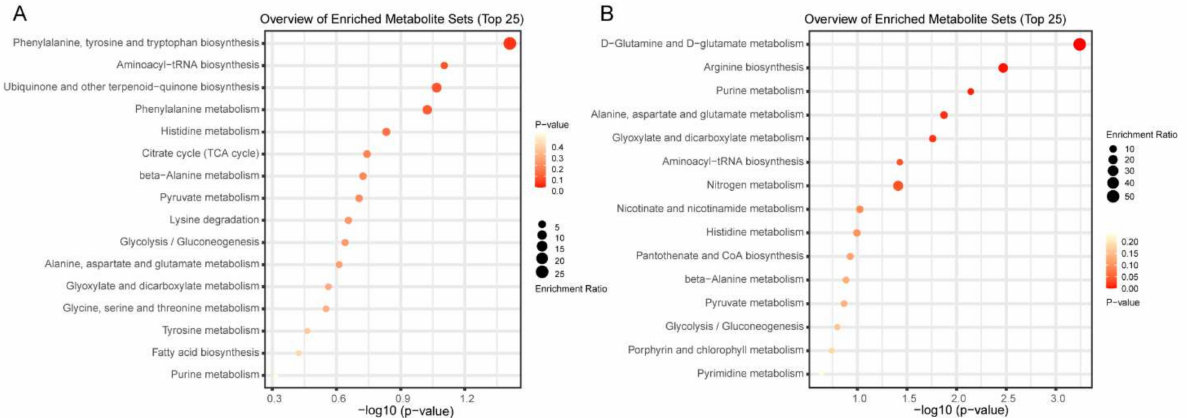
Figure 6. Metabolite set enrichment analysis of significantly altered metabolites in serum ( A ) and hippocampus ( B ) according to the KEGG database. Note: KEGG, Kyoto Encyclopedia of Genes and